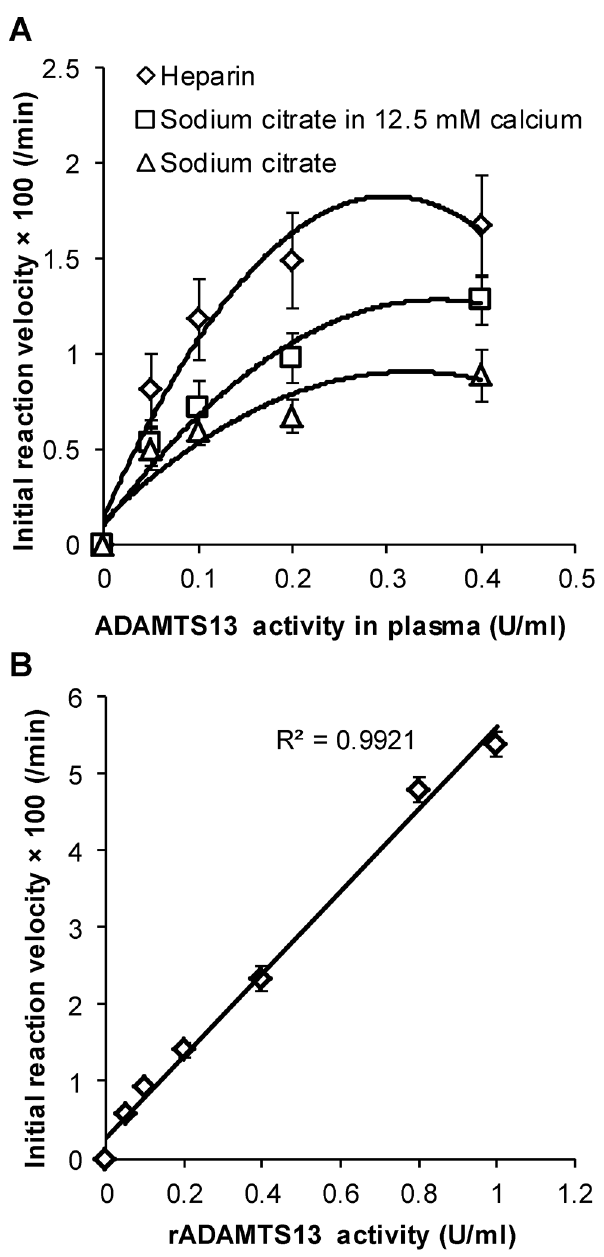
Fig 5. Dose-dependent proteolysis in runs containing plasma. A. Plasma was prepared from blood drawn using heparin or sodium citrate as anti-coagulant. This was diluted at indicated concentrations, into either normal Tris cleavage buffer or Tris cleavage buffer containing 12.5mM CaCl 2 . Microspheres bearing A2-77p-long were added. At all plasma dilutions, the cleavage reaction was maximum when using heparin as anti-coagulant. B. Microspheres bearing A2-77p-long were incubated with 25% HIP prepared in sodium citrate and 12.5 mM calcium. Recombinant ADAMTS13 was titrated at indicated concentrations. Proteolysis varied linearly with rADAMTS13 activity (R 2 =